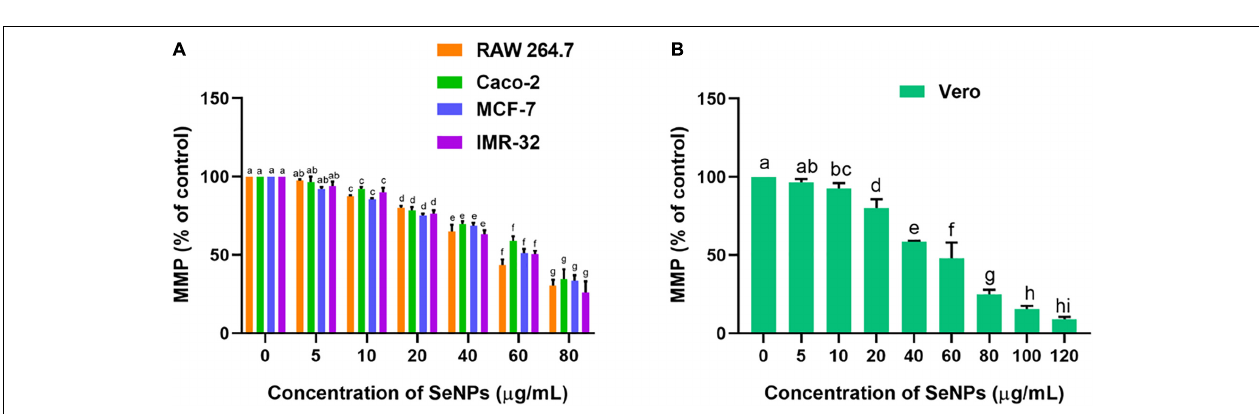
FIGURE 11 | Dose-dependent effect of SeNPs on LDH leakage of (A) cancer cells and (B) normal cells. The experiments in the study were carried out three times, each time independently. The mean and SD of the triplicate research were calculated using the results from each experiment. The bar graphs with different letters within the particular analysis were significant ( p -value ≤ 0.05) by Tukey’s test.